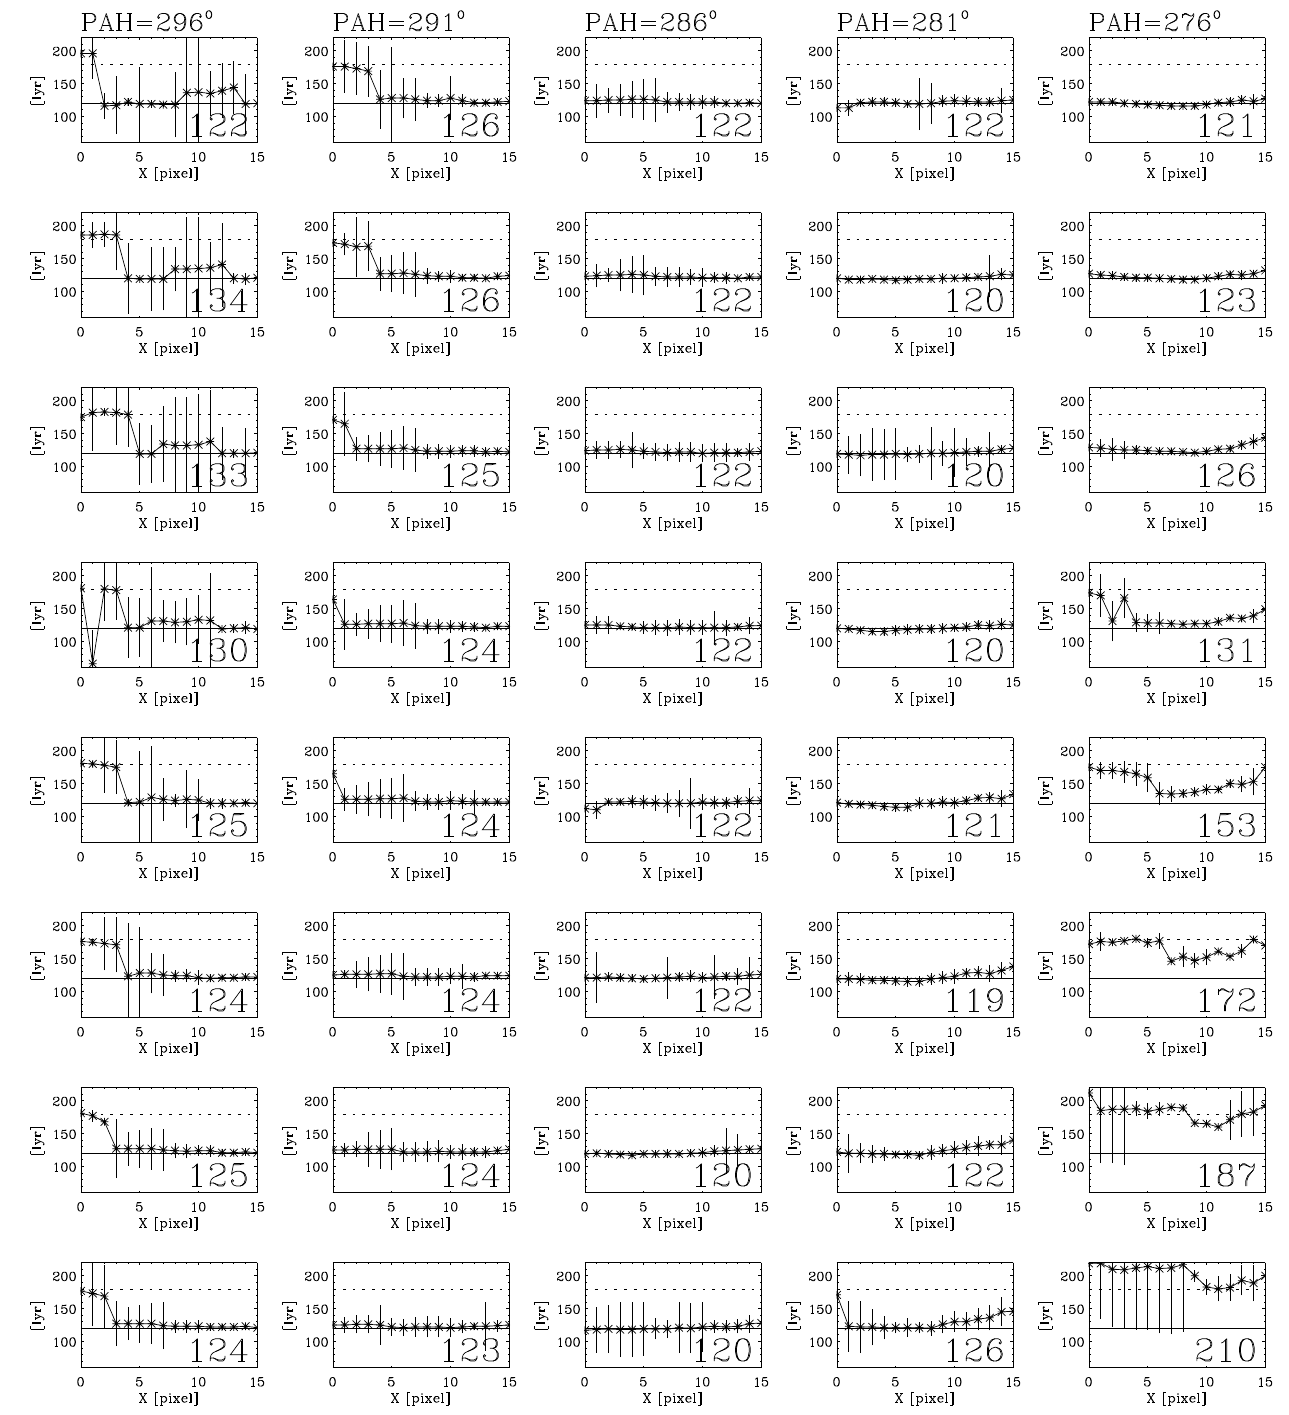
Fig. 2. Layer best , i.e., IR emission source locations inferred by the method of Liu and Lin (2008), as a function of position (in fiber head array) for the five coronal regions. The rows in each column represent the eight rows of the fiber head array (16 × 8). The error bar is defined to be the difference between σ p and σ χ (Fig. 1). The median value of the layer best in a row is shown as a number at the lower right corner of each box.